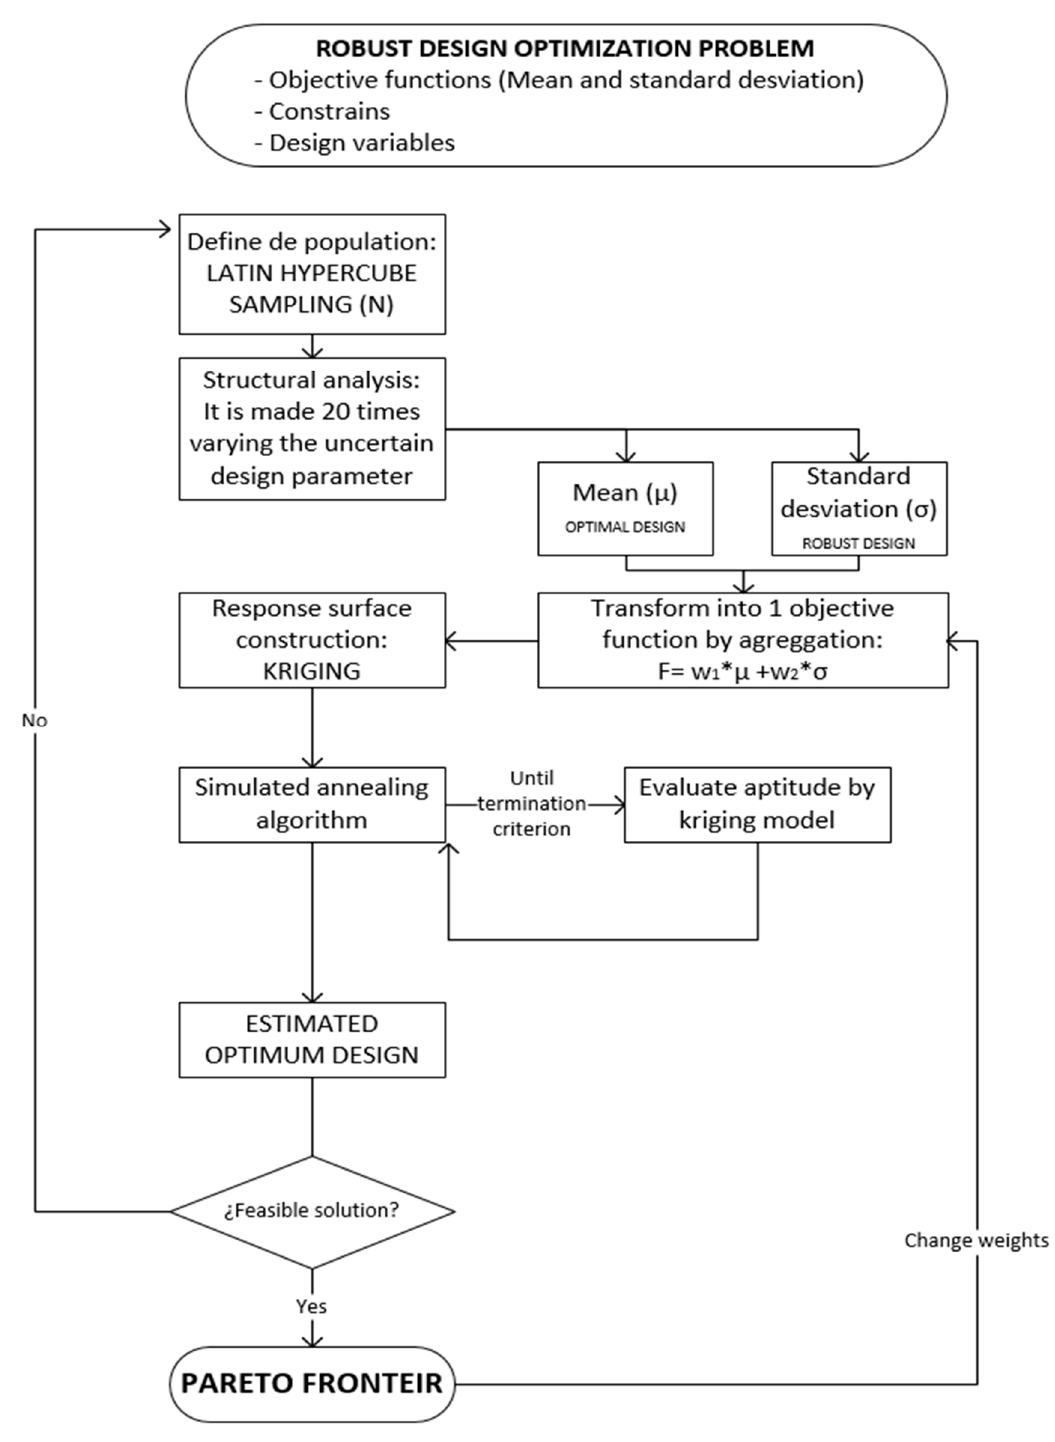
Figure 2. Flow diagram of robust design optimization.